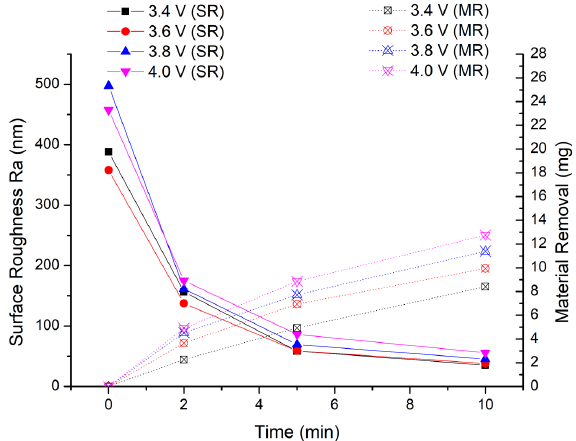
Figure 11. Optimization experiment of EMAF processing parameters.